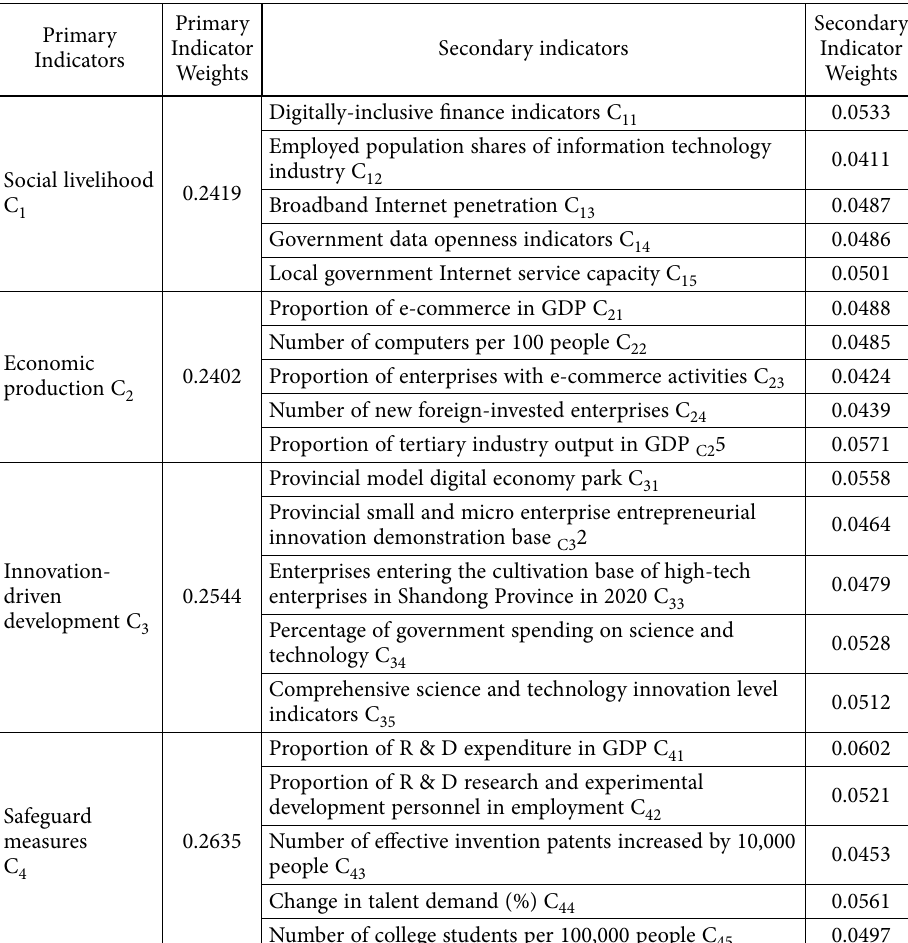
Table 1. Measurement indicators system of the new SCC construction